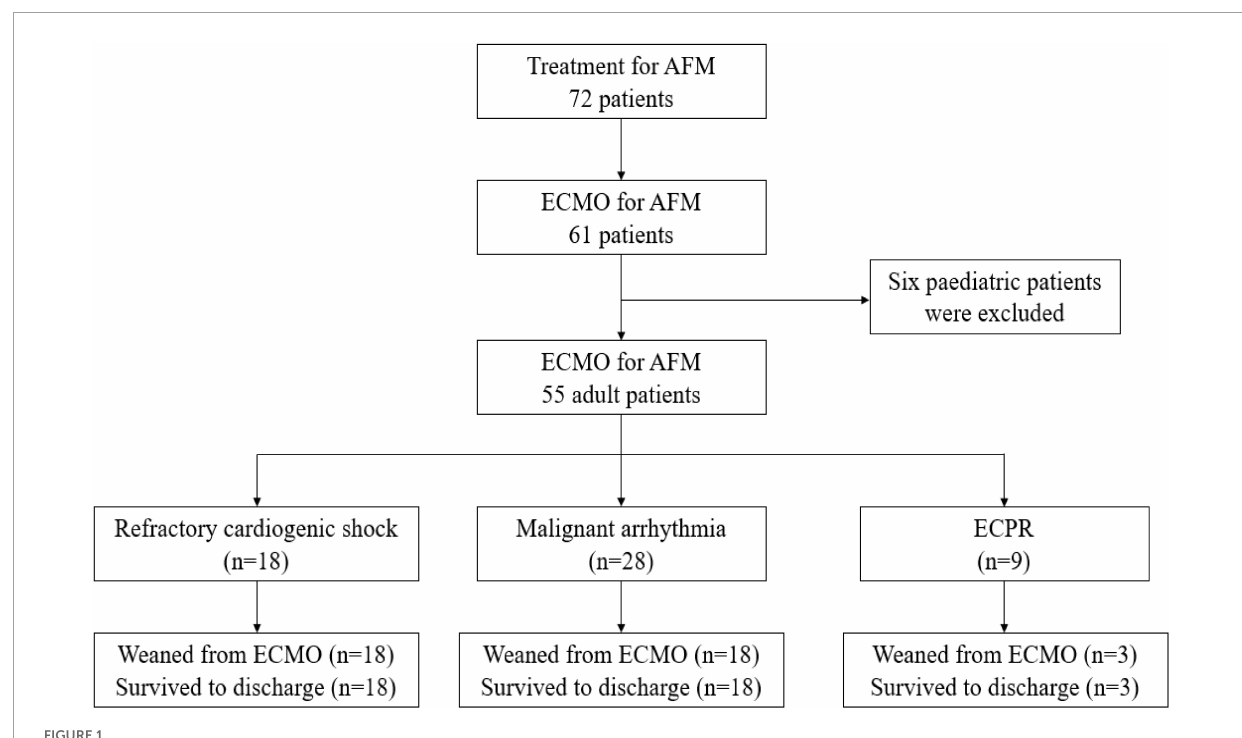
FIGURE1 A total of 785 patients with acute myocarditis were treated from January 2003 to January 2022, including 72 AFM. Among them, 61 patients underwent ECMO, and six pediatric patients were excluded. Fifty-five patients were finally enrolled. Eighteen patients received ECMO due to refractory cardiogenic shock, 8 were successfully weaned from ECMO, and 8 were discharged. Twenty-eight patients received ECMO due to malignant arrhythmia, 28 were successfully weaned from ECMO, and 28 were discharged. Nine patients received ECMO due to malignant arrhythmia, 3 were successfully weaned from ECMO, and 3 were discharged. Outcomes and reasons of patients supported with ECMO for AFM. AFM, acute fulminant myocarditis; ECMO, extracorporeal membrane oxygenation; ECPR, extracorporeal cardiopulmonary resuscitation.